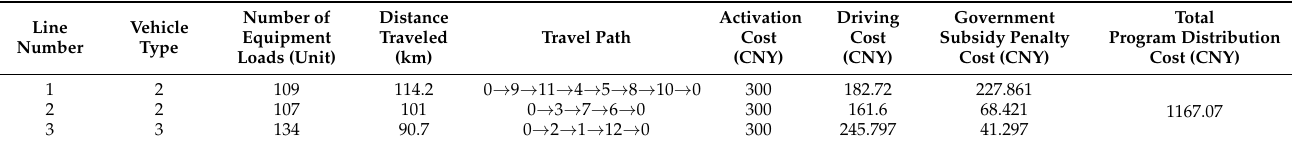
Table 13. Calculation results without considering demand